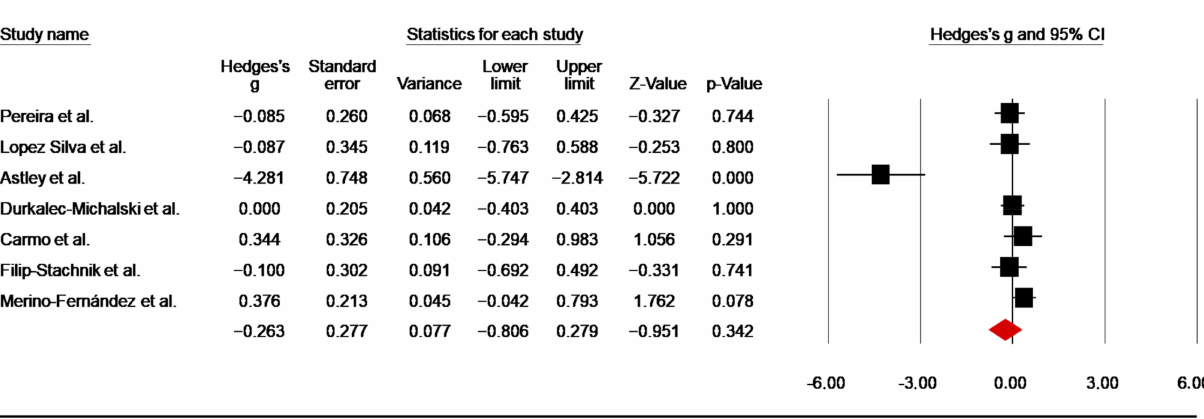
Figure 5. Forest plot of the total effect size of caffeine intake on SJFT index [45,47,50–52,55,57]. Judogi Strength-Endurance